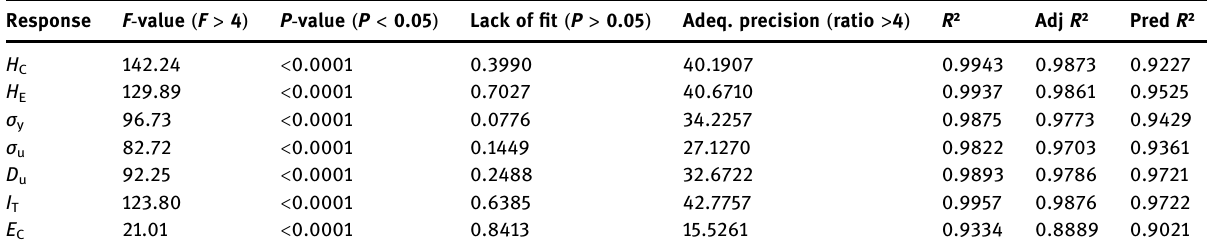
Table 3: Statistical tests of ECAP responses of commercial pure Cu Response